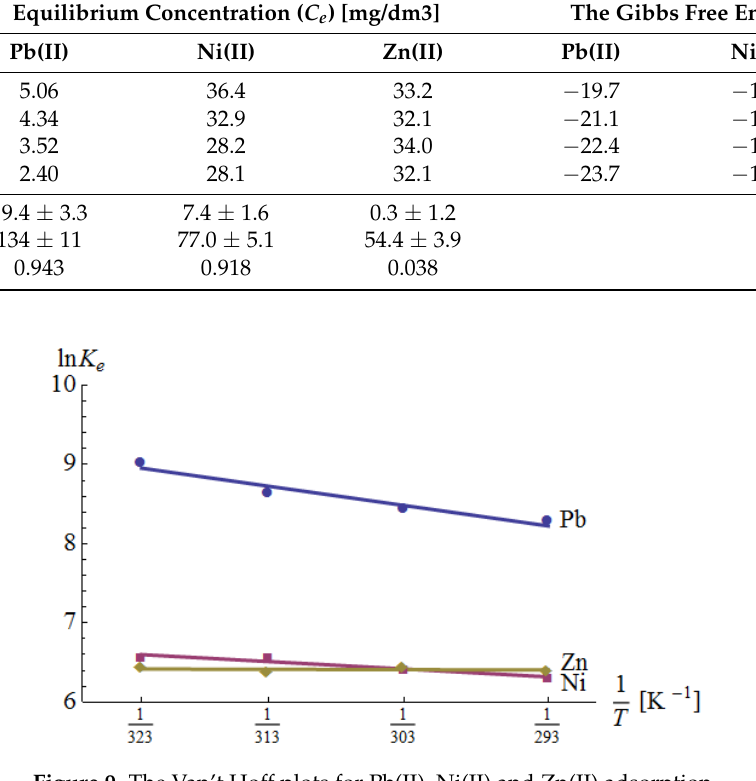
Figure 9. The Van’t Hoff plots for Pb(II), Ni(II) and Zn(II) adsorption.